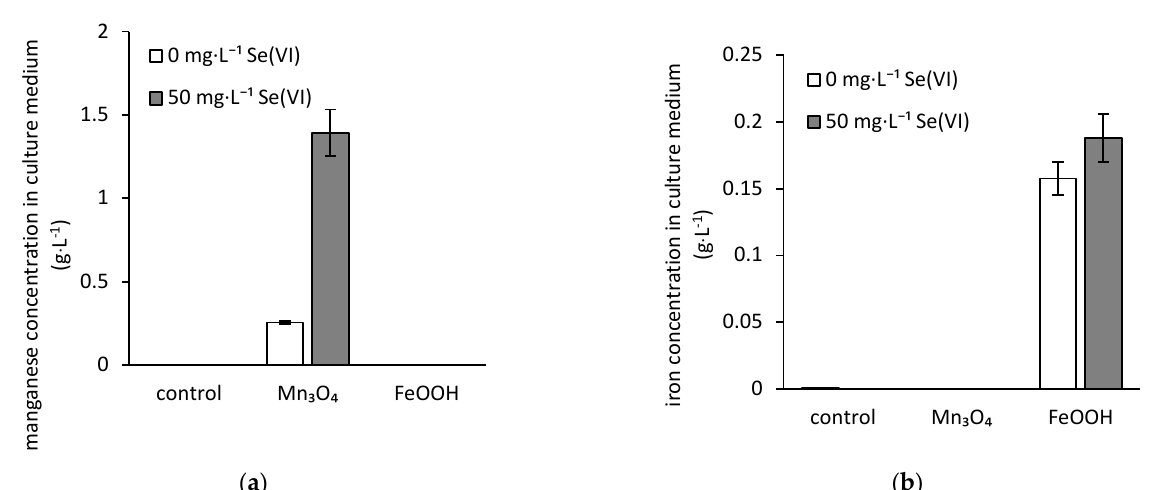
Figure 2. Changes in the concentration of dissolved ( a ) manganese and ( b ) iron in the selenium-free or selenate-treated culture media after the three-week static incubation of hausmannite (Mn 3 O 4 ) or amorphous ferric oxyhydroxides (FeOOH) in the presence of fungus Aspergillus niger (control represents the treatment without any solid inorganic phases).